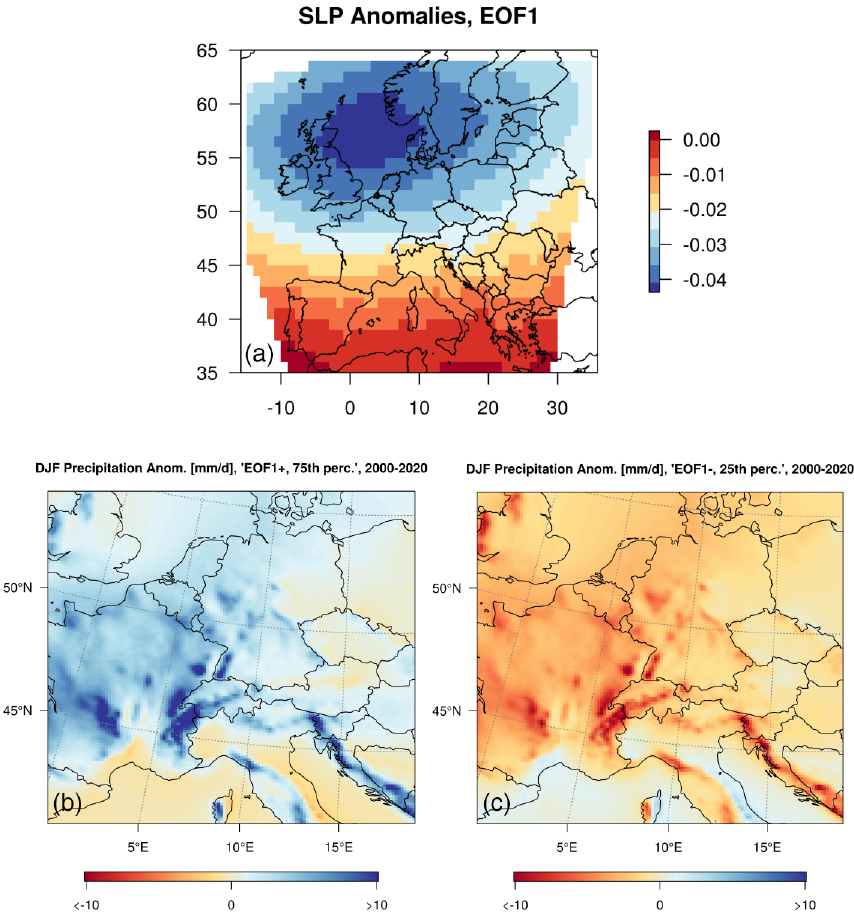
Figure 9. (a) First empirical orthogonal function of sea-level pressure over the full domain of the regional model. (b, c) Winter precipitation anomalies for the 25% of days that show the strongest (b) and weakest (c) projection on the pattern of the first EOF (i.e. days with a strong zonal SLP gradient and hence dominant westerly flow, b , and days with weak to absent zonal SLP gradients, c